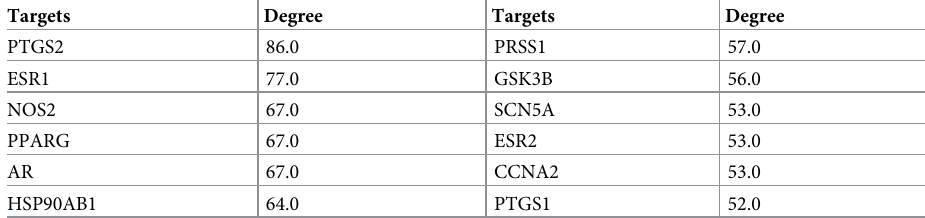
Table 2. A partial information table for the core